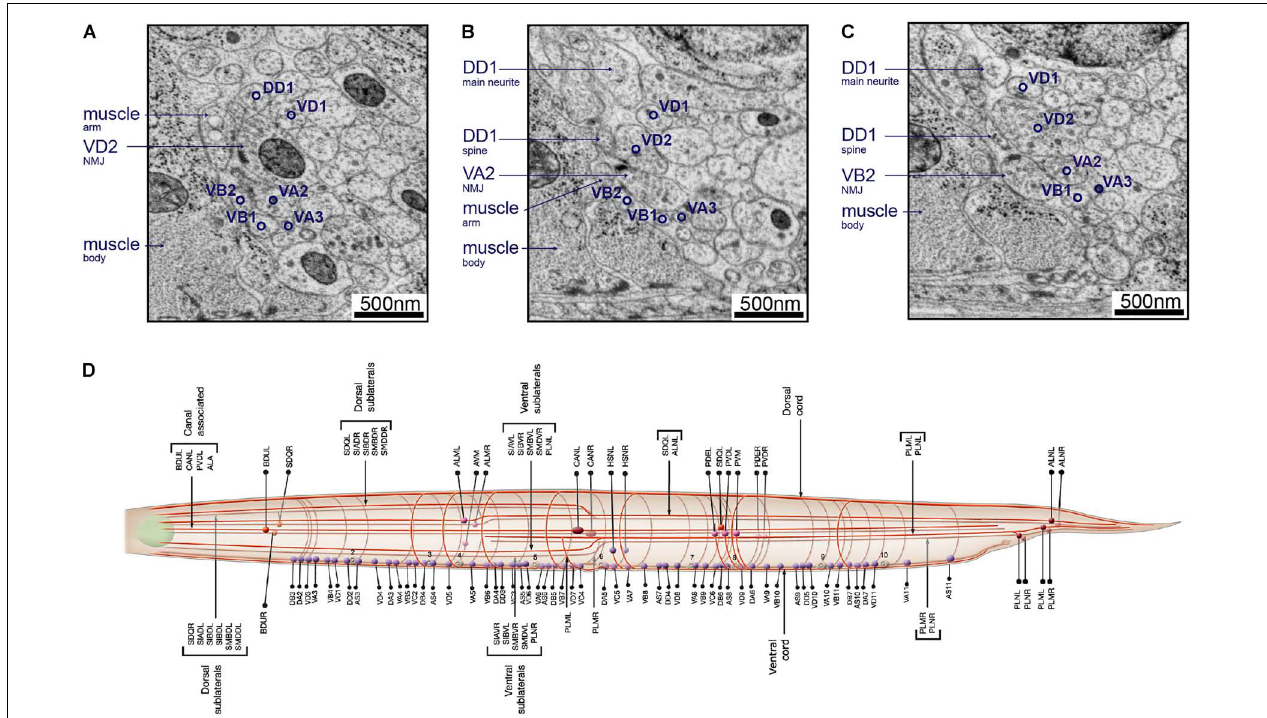
FIGURE 8 | Neurons can be identified from 3D volumes. Electron micrographs showing snapshots of part of the ventral nerve cord from an animal at the end of the second larval stage, imaged using SEM at 2 nm/pixel. (A) A VD2 NMJ is pointing laterally toward a muscle arm. This example also “hits” a projection from the VA2 motor neuron, but it is not clear if receptors are present. Some other motor neurons are also labeled, to give a sense of the relative position within the nerve cord. (B) A VA2 NMJ is pointing more dorsally, releasing onto a muscle arm, a DD1 spine and VD2. (C) A VB2 NMJ is also pointed dorsally, releasing onto muscle, a DD1 spine and VD2. (D) A cartoon of most of the commissure bundles in C. elegans , available on WormAtlas (Altun et al., 2002–2018) and based on The Mind of a Worm (White et al., 1986). The positions, handedness and commissure bundle partners are known, and very stereotypic. Bundles of neuron processes are shown as red cables. The cell bodies are denoted with spheres, and also have stereotypic positions along the body of the worm and relative to each other.